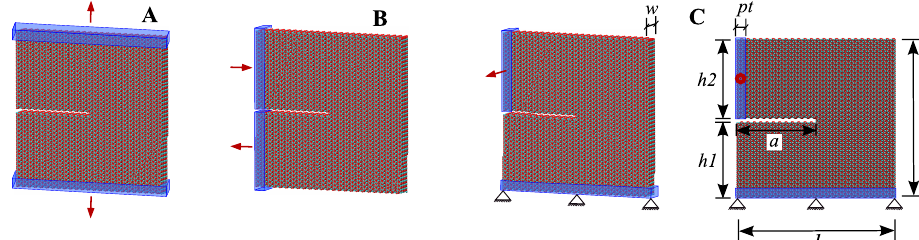
Figure 8. The three fracture modes of all-atom models of aragonite tablets. ( A ) Schematic representation of the perspective view of Mode I fracture. The model was pulled on both sides with constant velocities, such that pulling directions are perpendicular to the crack depth, which is marked by red arrows. ( B ) The Mode II model was loaded parallel to the crack surfaces with pushing the top and pulling bottom portion of the model. ( C ) In the Mode III, or tearing mode, the top portion of the model was loaded parallel to the crack front the crack surfaces, in which bottom portion was fixed. The dimension a denotes the crack depth, while h , h 1, h 2, l , w and pt represent the total height, bottom part height, top part height, length, width and pulling layer thickness,